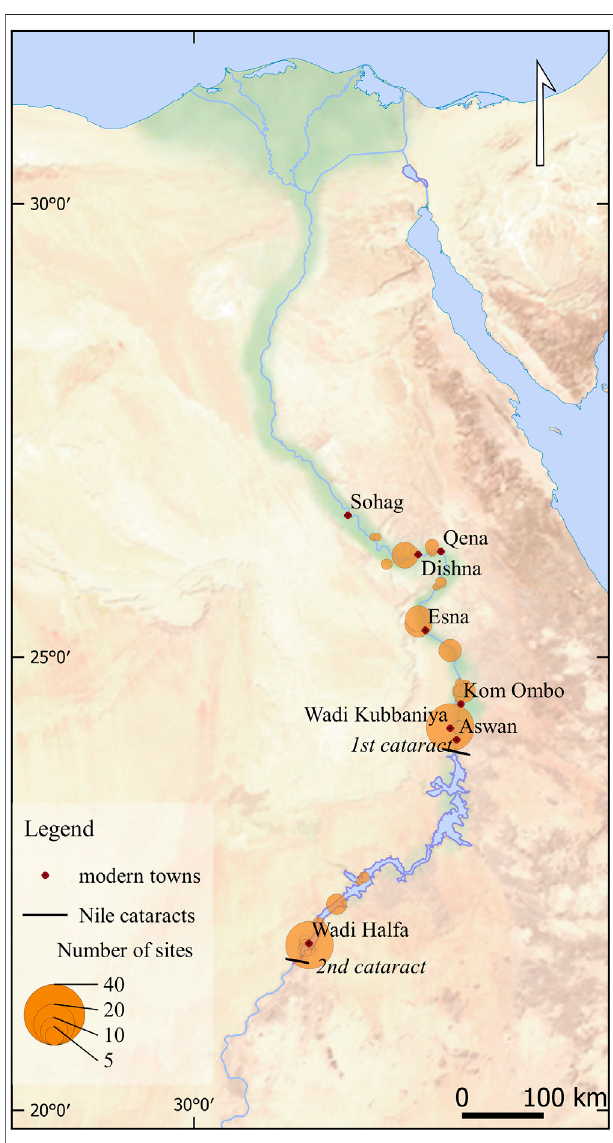
FIGURE 3 | Geographic distribution of Late Palaeolithic sites in the main Nile Valley. Number of sites were counted using a square grid with each square side measuring ca. 5 kms. Created in QGIS v. 3.15 (QGIS Development Team, 2017) using Natural Earth Data.